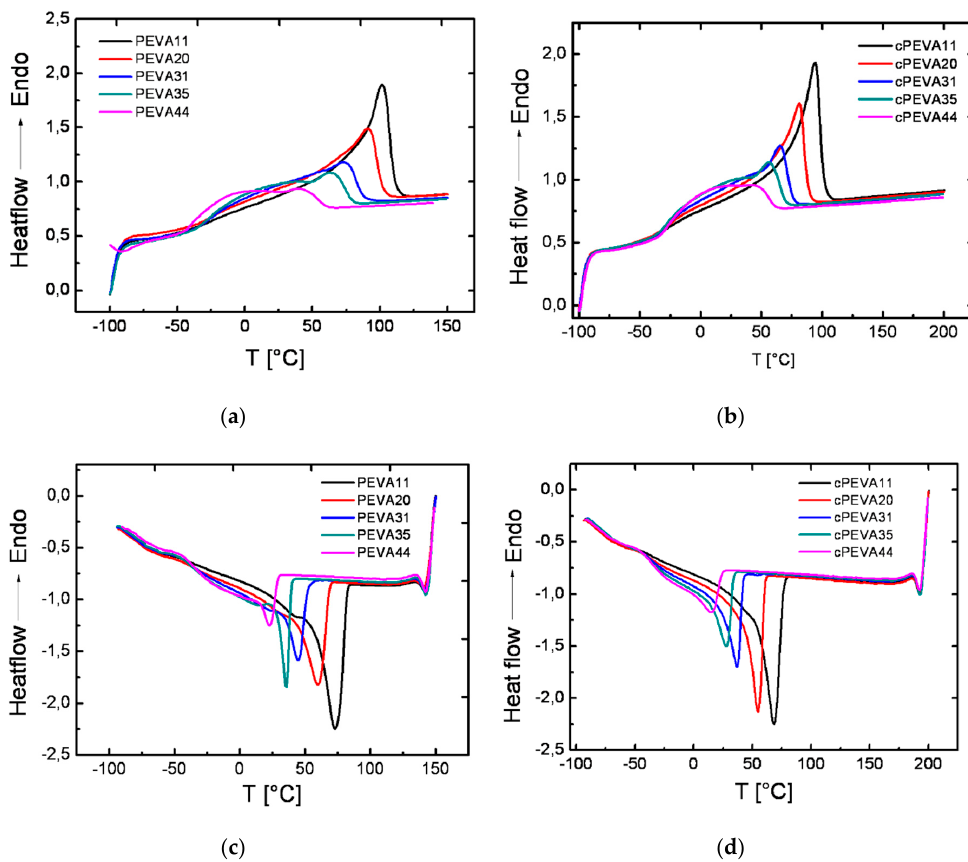
Figure 5. The second heating curves of DSC thermograms for PEVAs at a temperature range of − 100 ◦ C to 150 ◦ C ( a ) and cPEVAs determined between − 100 ◦ C and 200 ◦ C ( b ) with a heating rate of 20 C · min − 1 , where the melting temperature ( T m ) was obtained as the endothermic peak maximum in the heating curve and the glass transition temperature ( T g ) was shown as a step-wise transition in the thermograms, partly overlapped with the melting peak. The first cooling step of DSC thermograms for PEVAs with a temperature range of − 100 ◦ C to 150 ◦ C ( c ) and cPEVAs determined in the temperature range between − 100 ◦ C and 200 ◦ C ( d ) with a cooling rate of 20 C · min − 1 , where the crystallization temperature ( T c ) was determined as the peak maximum.